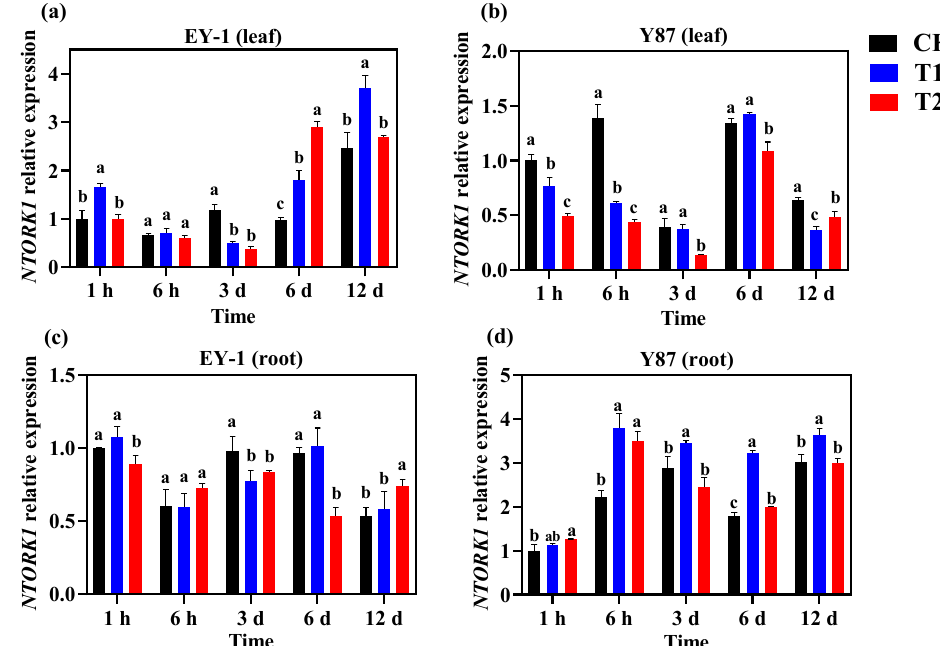
Figure 5. Relative expression levels of the NTORK1 gene in EY-1 leaf ( a ), root ( c ) and Y87 leaf ( b ), root ( d ) as determined by real-time PCR. CK, control; T1, topping; T2, IAA application after topping. The mean ± SE of three replicate samples are shown as error bars. Means with same lowercase letters have no significant difference ( p = 0.05) in the LSD test.